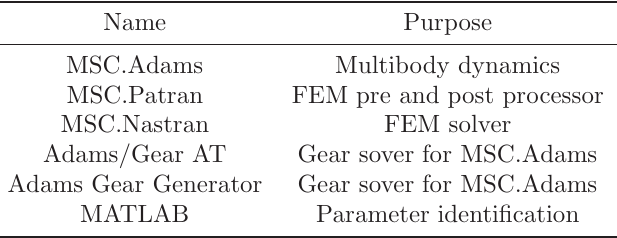
Table 1: Software used in this